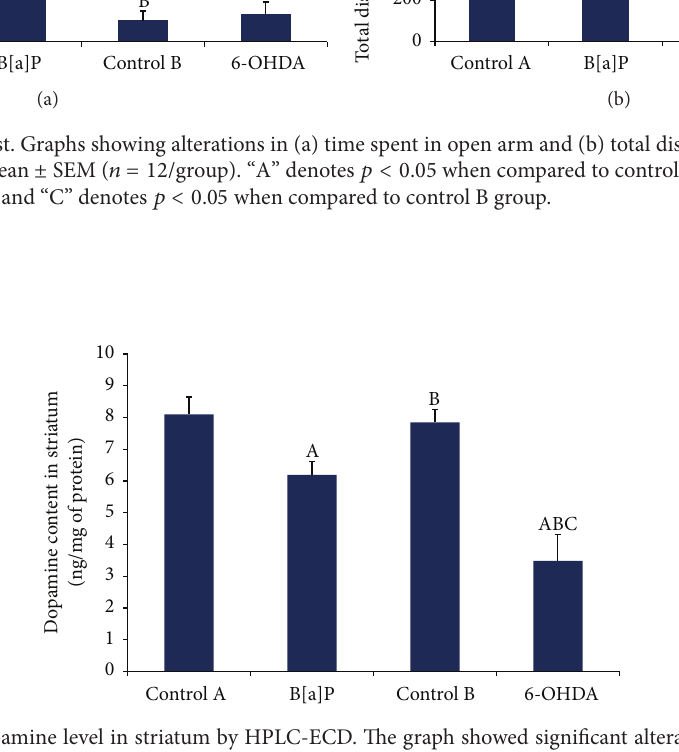
Figure 4: Quantification of dopamine level in striatum by HPLC-ECD. The graph showed significant alteration in striatal dopamine level following B[a]P and 6-OHDA administration when compared to their respective control groups. Values are expressed as mean ± SEM ( 𝑛 = 6 /group). “A” denotes 𝑝 < 0.05 when compared to control A group, “B” denotes 𝑝 < 0.05 when compared to B[a]P group, and “C” denotes 𝑝 < 0.05 when compared to control B